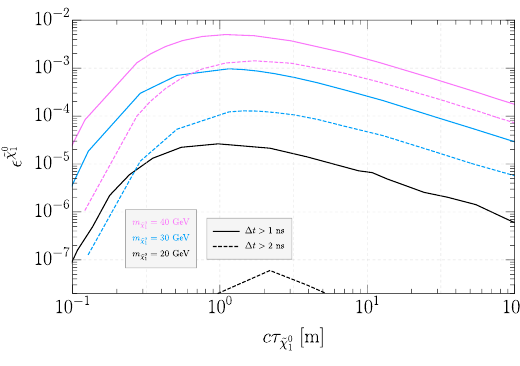
Figure 6 . Acceptance (cid:15) ˜ χ 0 1 as a function of cτ